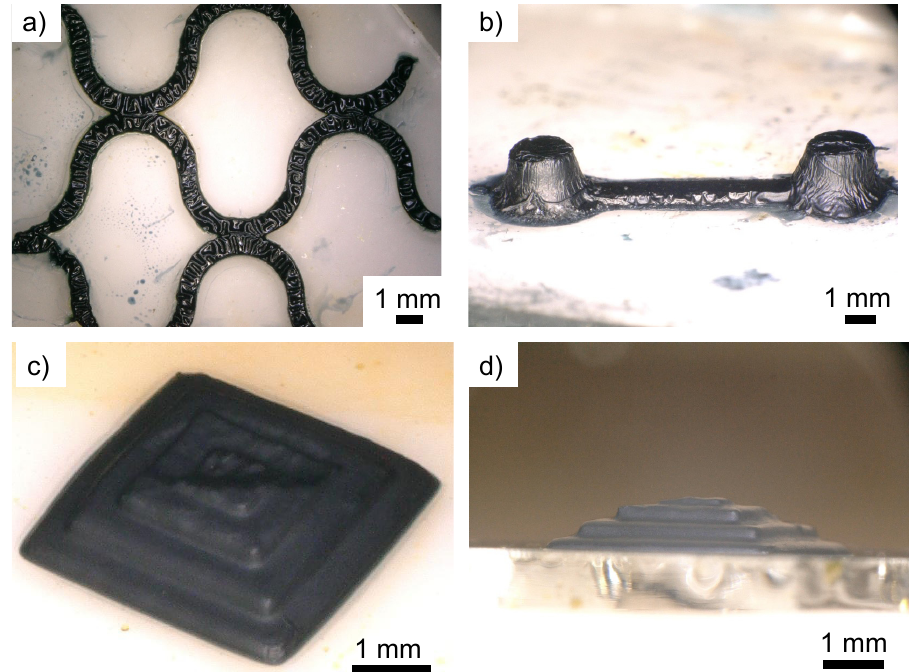
Figure 12. Examples of fabricated 2D and 3D structures. ( a ) 2D geometric model; ( b ) 3D two towers and a bridge model; ( c ) bird’s eye view of 3D stepped pyramid; and ( d ) side view of 3D stepped pyramid. Resin with 5% EDOT was used for fabrication. Resin with 5% EDOT was used for modeling; 2D and 3D structures were modeled with laser intensities of 0.2 and 0.04 mW, respectively.